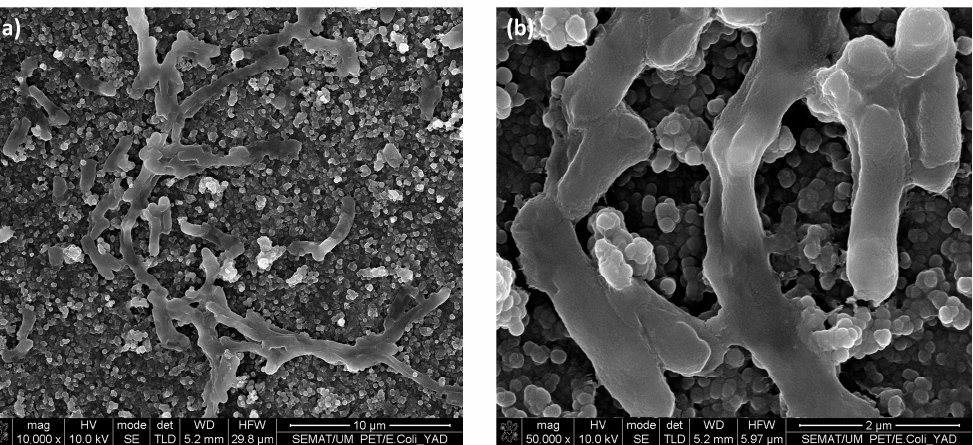
Figure 9. SEM visualization of NPs treated samples with different magnifications ( a ) 10,000× and ( b ) 50,000×, after the bacterial adhesion test (4 h).